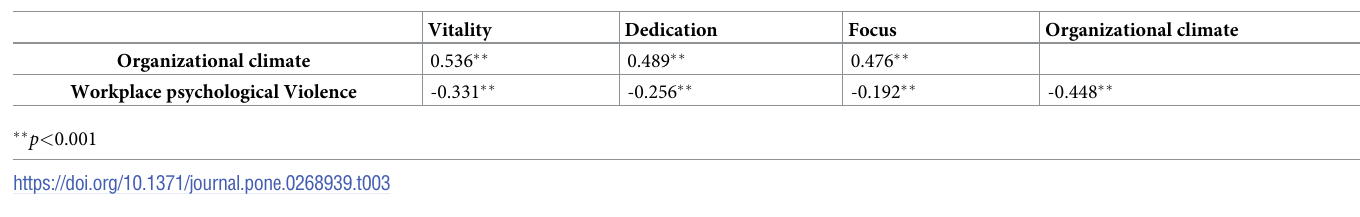
Table 3. Partial correlation results of each